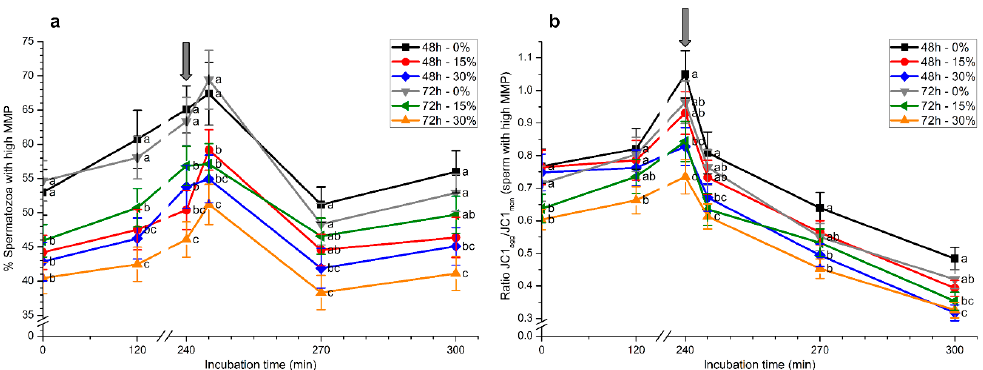
Figure 7. Percentages of spermatozoa with high mitochondrial membrane potential (MMP; ( a )) and their JC1 agg /JC1 mon ratios ( b ) during in vitro capacitation and progesterone-induced acrosomal exocytosis (300 min) after previous storage of spermatozoa at 17 °C with different concentrations of seminal plasma (0%, 15%, and 30%) for 48 h or 72 h. Grey arrow indicates the time at which 10 μ g/mL progesterone was added to induce acrosomal exocytosis (i.e., 240 min). Different letters mean significant ( p < 0.05) differences between treatments at a given time point. Data are shown as mean ± SEM for seven independent experiments.